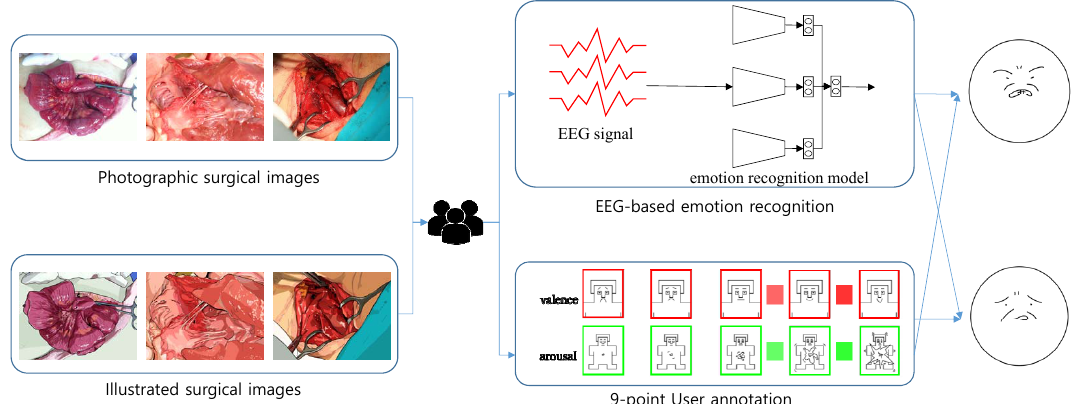
Figure 4. Overview of our framework.